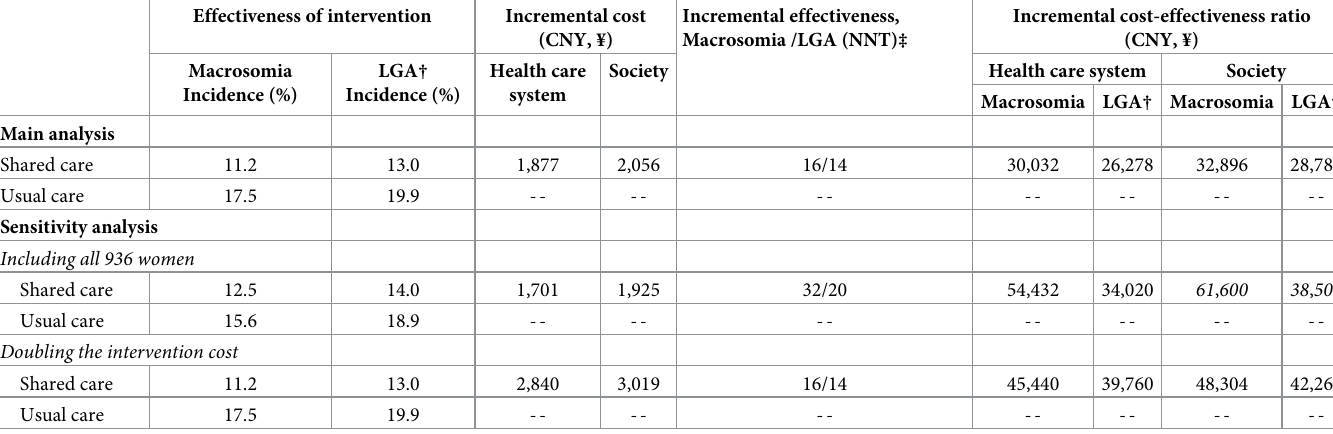
Table 4. Effectiveness and cost-effectiveness of a lifestyle intervention program for women with gestational diabetes in China. Effectiveness of